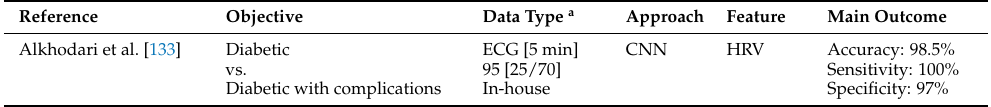
Table 10. Deep learning methods for diabetes